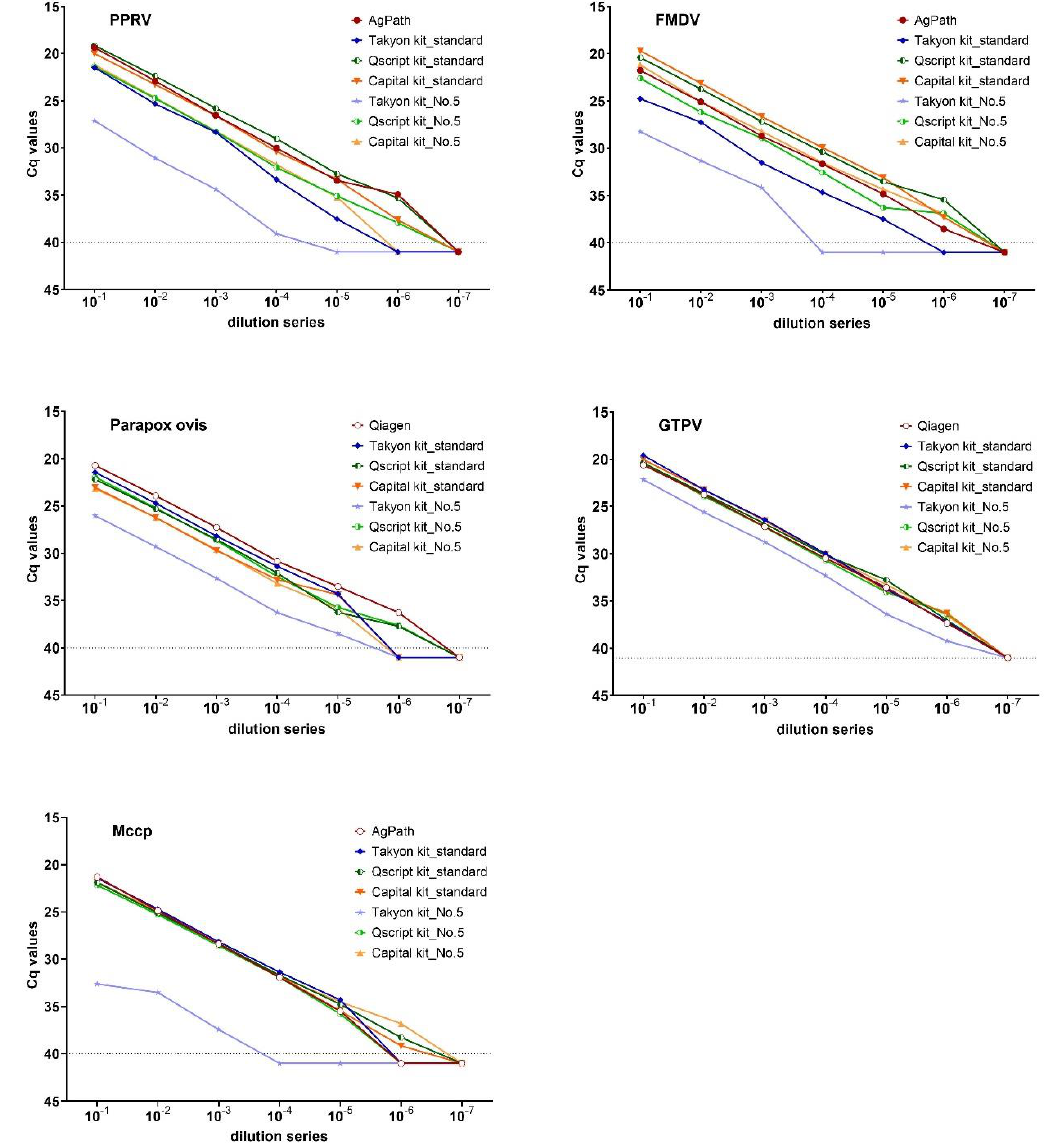
Figure 5. Test series with three lyophilized kits and five different pathogens: comparison of a well-established PCR protocol (named “AgPath” or “Qiagen”), the standard protocol (named “standard”) of the lyophilized kit, and the maximal shortened protocol (named “No.5”) of the corresponding kit. The kits used for the validation of the dilution series: AgPath = AgPath-ID™ One-Step RT-PCR Reagents; Qiagen = QuantiTect Multiplex-PCR Kit NO ROX. The three lyophilized kits used: Taykon kit; Qscript kit and Capital kit. The five different pathogens tested: PPRV, FMDV, Parapoxvirus ovis, GTPV, Mccp.